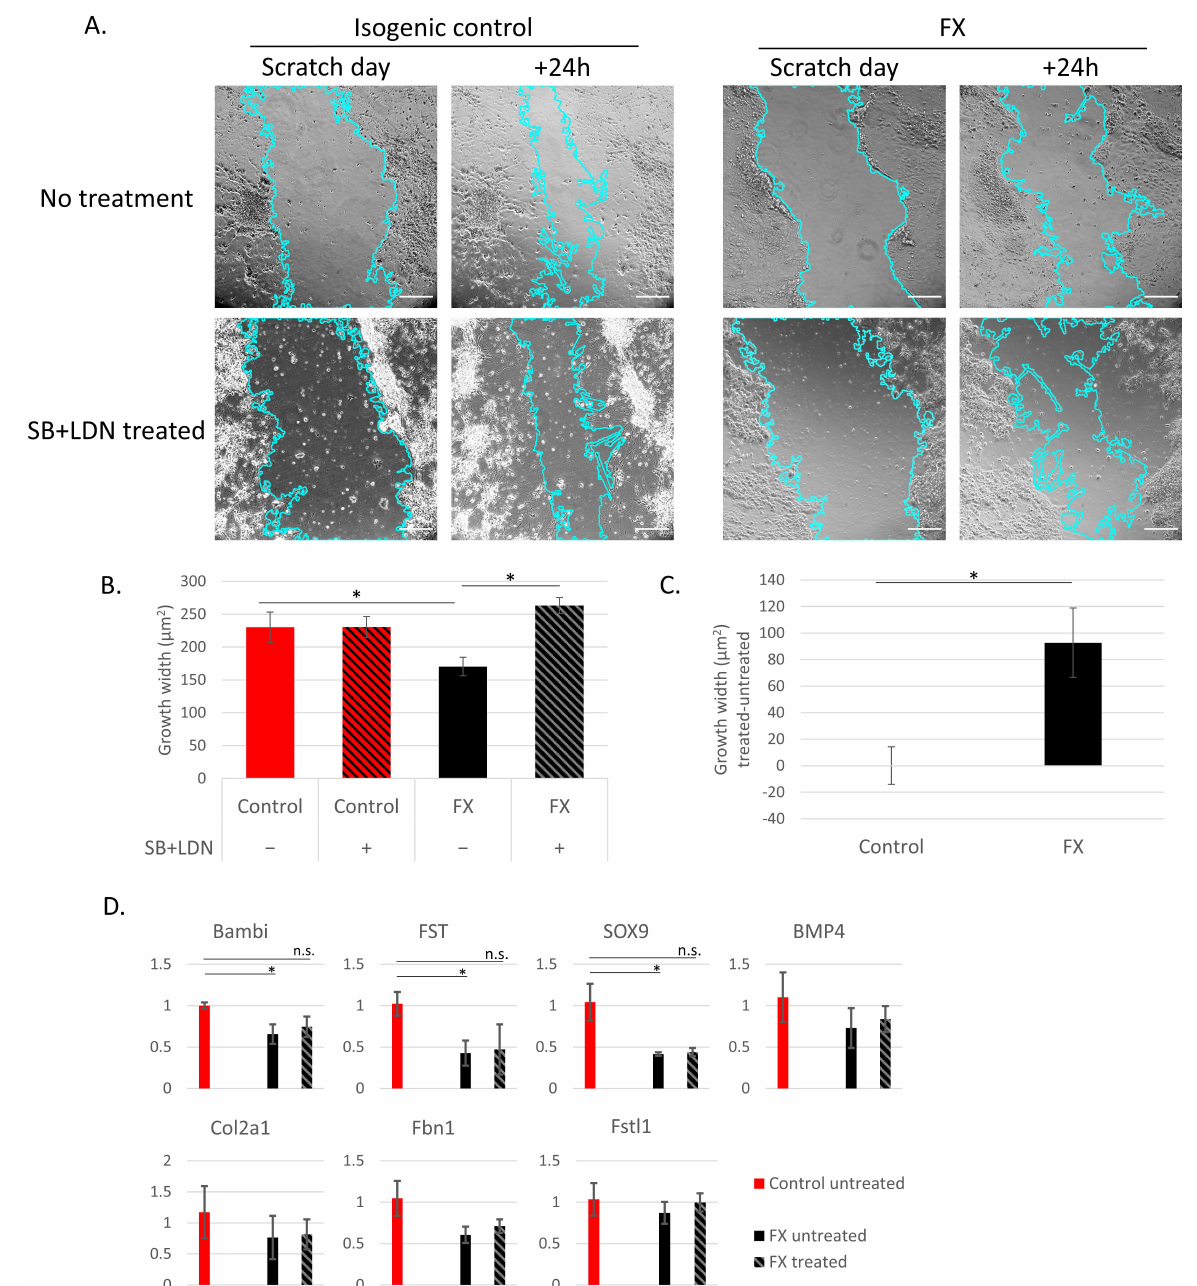
Figure 5. Fragile X-derived neurons display a neurite outgrowth defect. ( A ) Representative images of isogenic control (left) and FX (right) clones, after the scratch and 24 h following it, with (upper) or without (lower) SB431542 and LDN-193189 (10 µ M and 250 nM, respectively). Surface area analyses was measured using ImageJ software 1.53f51 (NIH, http://rsbweb.nih.gov/ij/, USA). Scale bar: 200 µ m. ( B ) Quantified values are growth width average calculated as the difference between the averaged cut width at the cutting time and the width left after 24 h. All values are mean ± SEM (* p < 0.0001; One-way ANOVA). Data obtained of each clone from three independent experiment and 30 fields, or more, were analyzed in each group. ( C ) Quantification of the difference in growth width between the treated and untreated cultures (* p < 0.05; Paired Student’s t -test). ( D ) RNA expression of DEGs from the BMP pathway analyzed by qRT-PCR at 14 DIV, in FX and control cells after a day with or without treatment of the TGF β /BMP/SMAD inhibitors, SB431542 and LDN-193189.